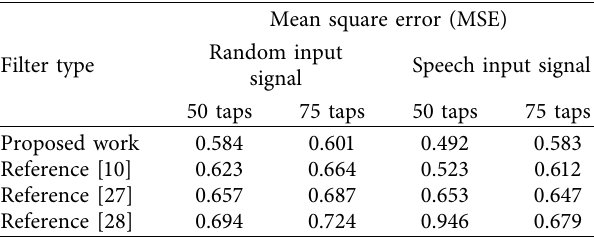
Table 4: MSE comparison in speech and random